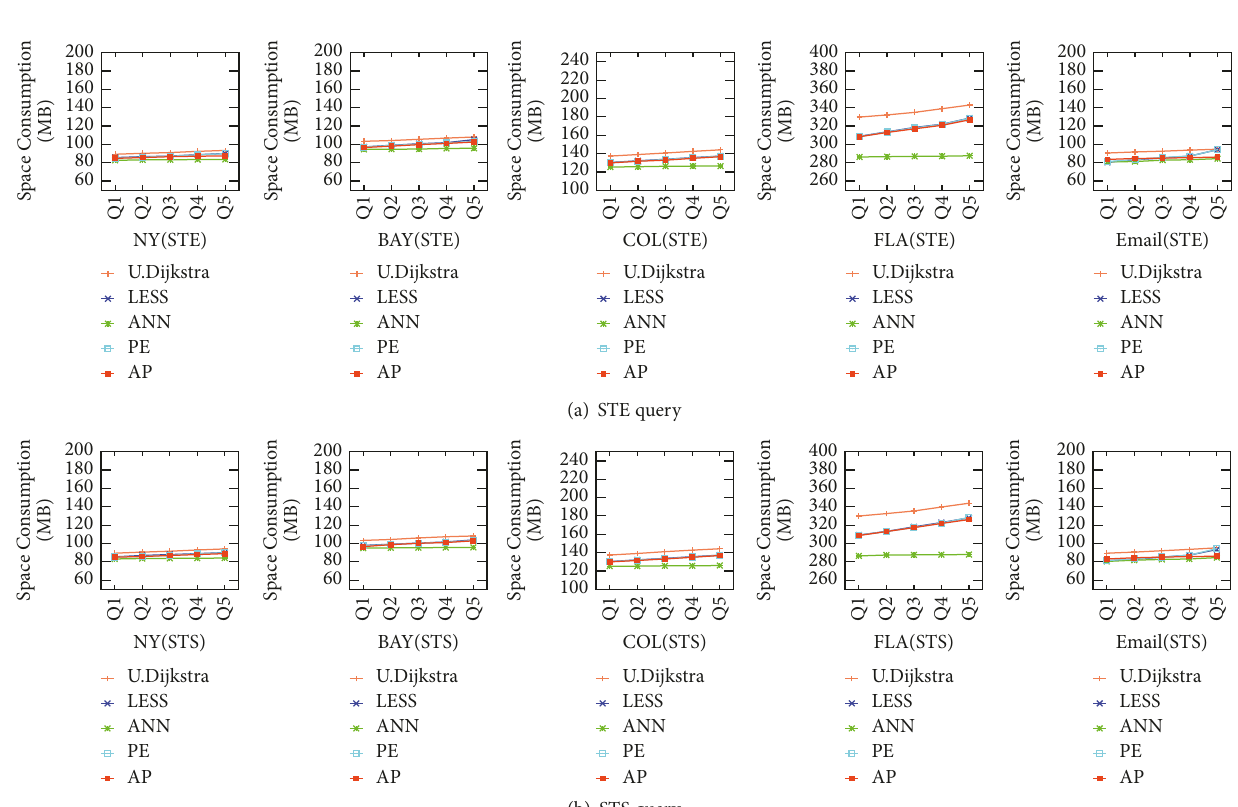
Figure 6: Query efficiency on Q11-Q15.